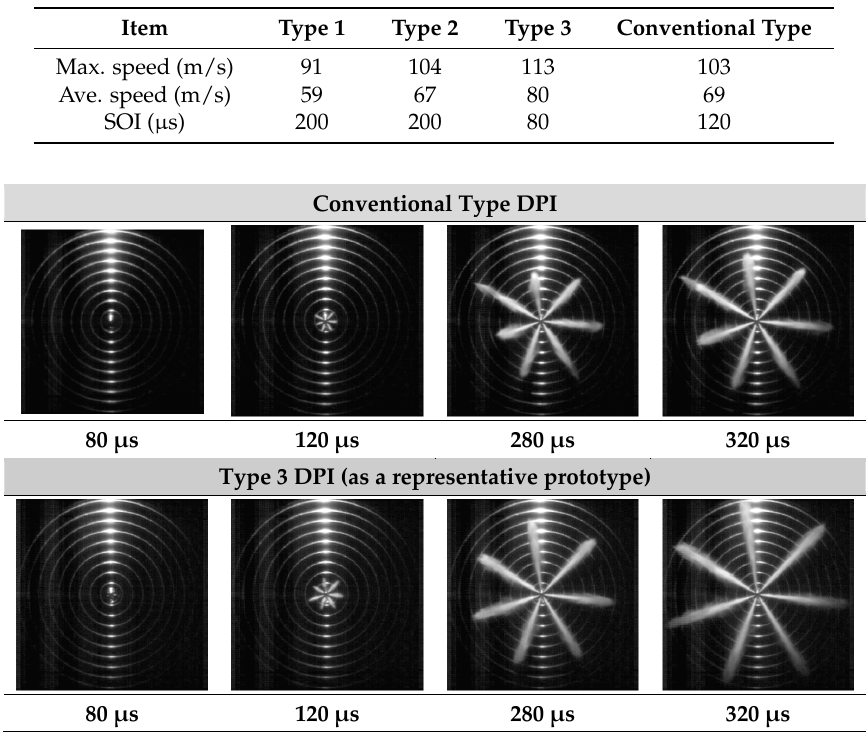
Figure 16. Comparison of Mie-scattering spray image between conventional type and Type 3 DPI.